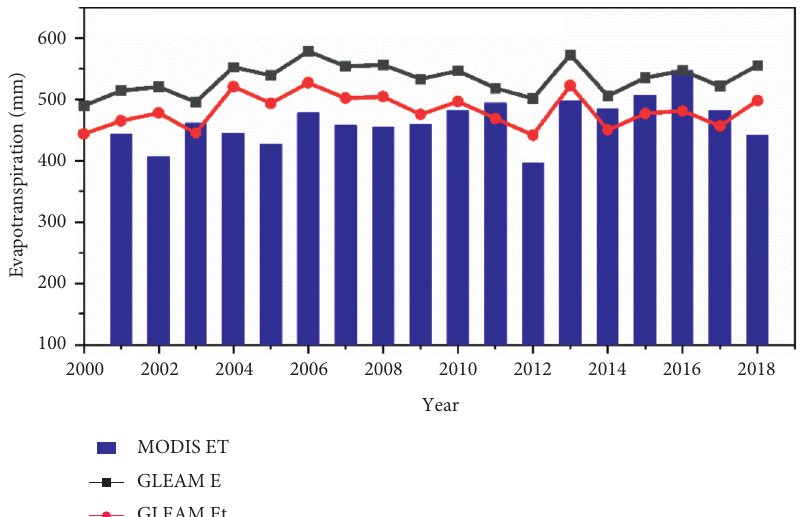
Figure 13: The change of evapotranspiration by GLEAM data and comparison with MODIS data from 2001 to 2018 in upper Taohe River basin.